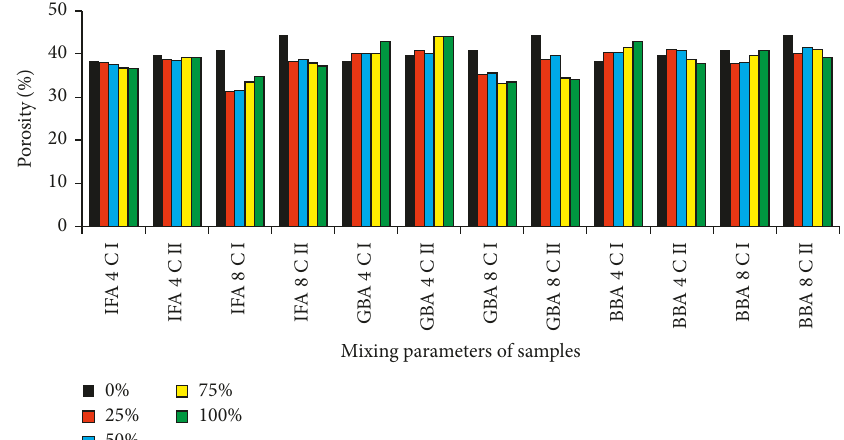
Figure 7: Relationship of porosity of the samples having different admixtures. IFA: ˙Isken FA; 4: BC40; 8: BC80; C: CEM; GBA: G¨oknur BA; BBA: Bor